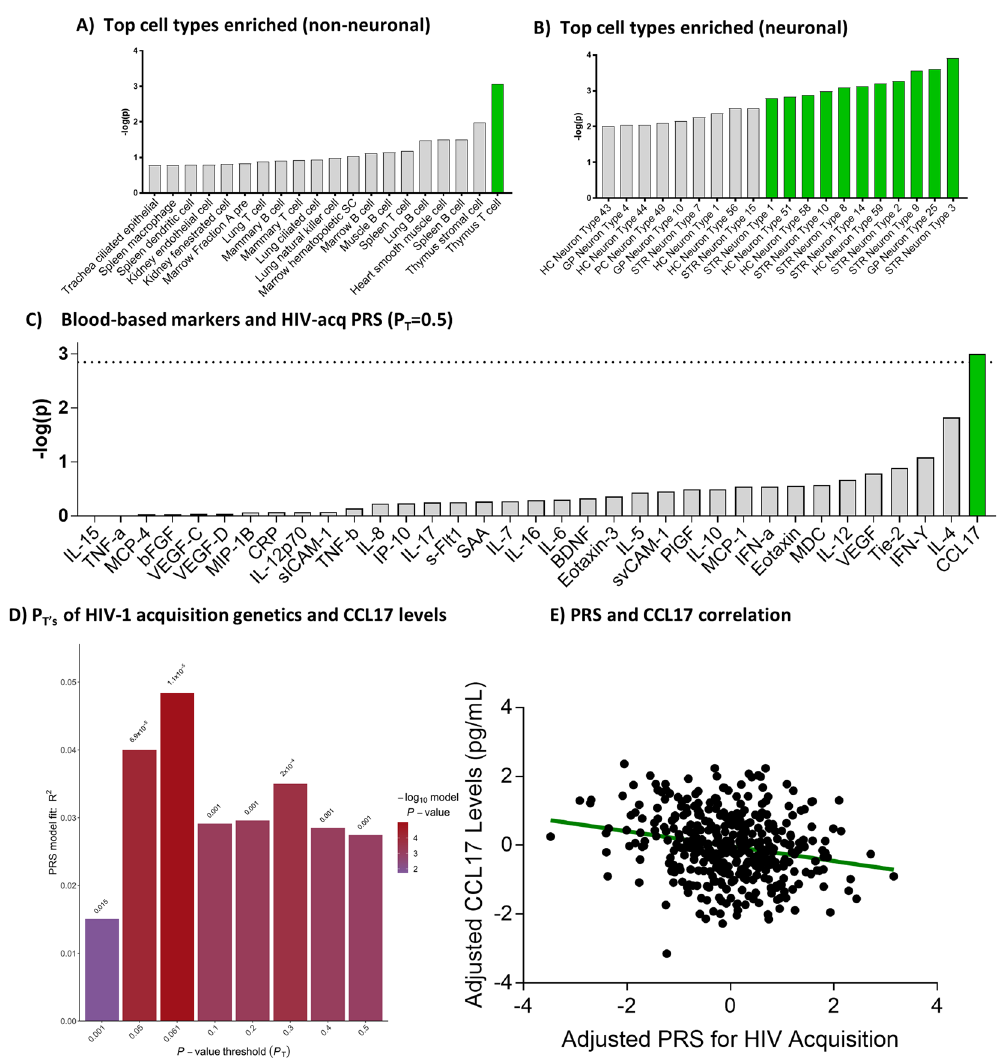
Figure 3. HIV-1 acquisition genetics significantly overlaps with the expression profile of T-cells and neurons, and correlates with blood levels of CCL17. ( A) Top 20 enrichment signals observed for murine non-neuronal cell types. ( B) Top 20 enrichment signals observed for murine neuronal cell types. Green indicates significance under a false discovery rate of 10%. ( C) Plot showing -log(p) of the association between 35 markers and a polygenic risk score for HIV-1 acquisition. The dashed line indicates Bonferroni significance. (D) Sensitivity analysis revealed that PRS at every P T significantly correlated with CCL17 levels in blood, with the highest significance at P T = 0.061. ( E) Correlation between PRS for HIV-1 acquisition (P T = 0.061) adjusted for seven population dimensions, and CCL17 levels adjusted for age, gender, BMI, ethnicity, and smoking